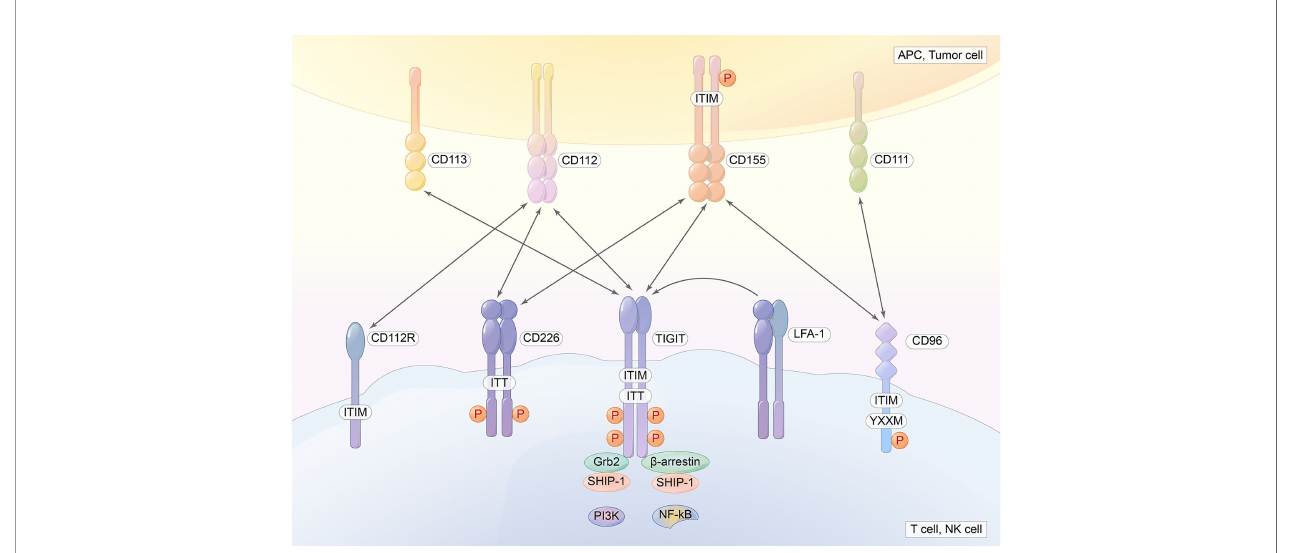
FIGURE 4 | TIGIT contains an extracellular immunoglobulin variable domain, a type I transmembrane domain, and a short intracellular domain with one immunoreceptor tyrosine-based inhibitory motif (ITIM) and one immunoglobulin tyrosine tail (ITT) motif. CD155, CD112, and CD113 are ligands for